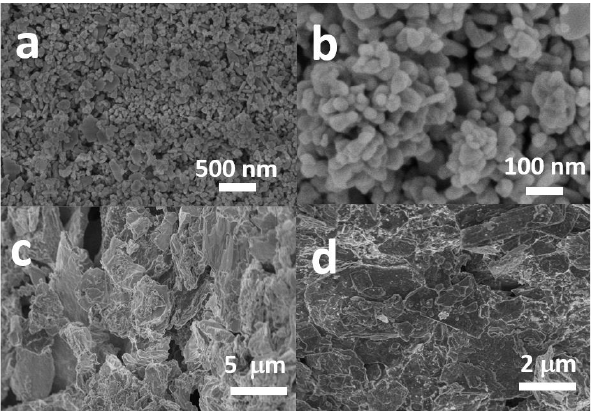
Figure 1. Field-emission scanning electron microscopy (FESEM) images of the different components of the catalysts: ZnONPs at 50,000× ( a ) and 100,000× ( b ); rGO ( c ); and MoS 2 ( d ).